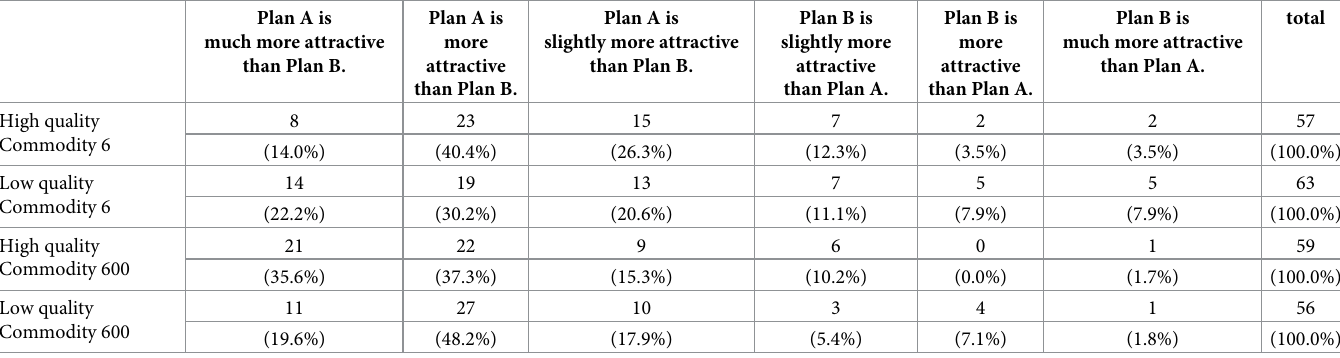
Table 9. Frequencies and percentages of choice in the commodity problem across 4 categories (negative frame). Plan A is much more